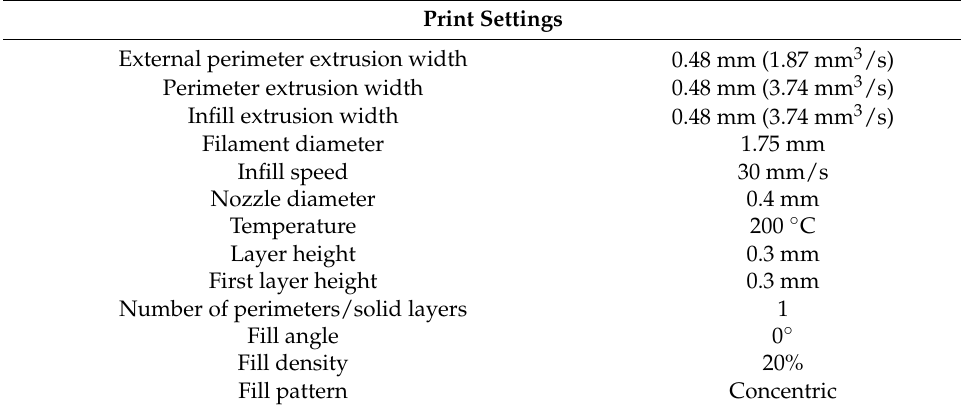
Table 3. Printing Parameters of Test Specimen.